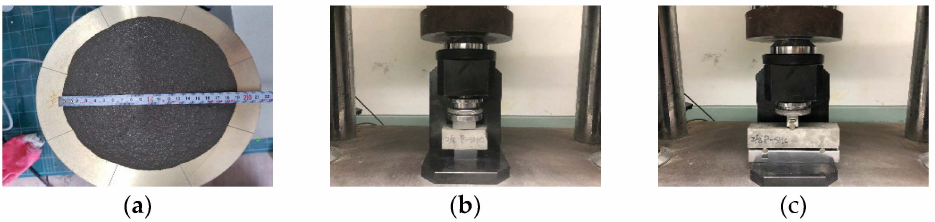
Figure 4. Reaction mechanism of the complex capsule: ( a ) flow test; ( b ) compressive strength test; ( c ) flexural strength